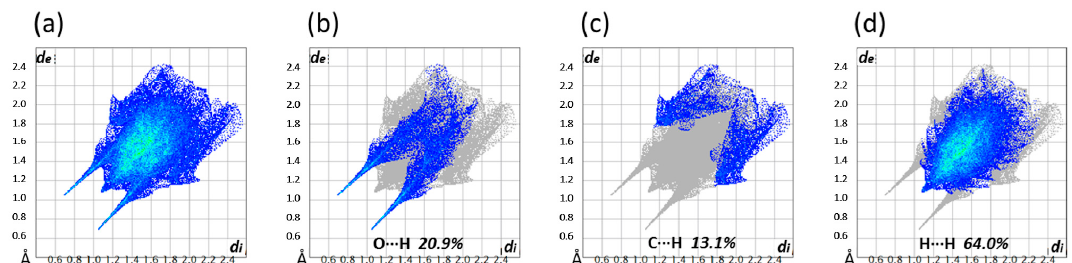
Figure 6. ( a ) The full two-dimensional plot for the d e and d i contact distance functions and those delineated for the specific contacts: ( b ) O···H; ( c ) C···H; ( d ) H···H. The contributions of specific contacts to the intermolecular interactions are shown as percentages. Other contact type contributions not shown here: C···O (2.0%) and C···C (0.1%).